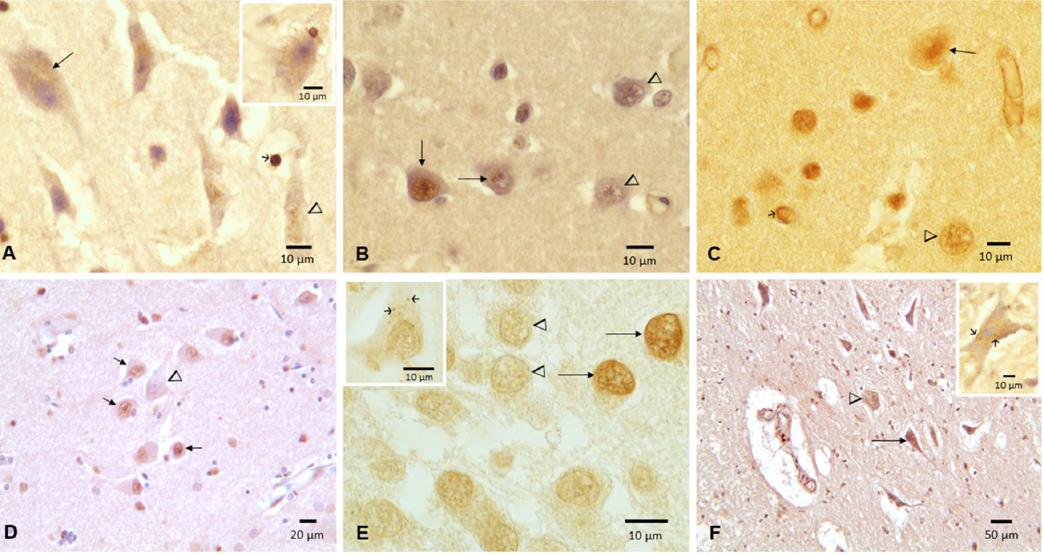
Figure 6. TDP-43 Immunohistochemistry in frontal and temporal cortex, hippocampus and cervical motor neurons. ( A ) Twenty-four y old male showing a frontal pyramidal neuron with negative nu- clear IR and dash-like cytoplasmic positive IR (long arrow), a pyramidal neuron with cytoplasmic IR and negative IR nucleus (arrowhead) and a glial cell with strong nuclear IR (short arrow). Insert shows a coil tangle in an oligodendroglia cell close to a frontal motor neuron with negative IR nu- cleus and a cytoplasmic IR. DAB counterstained with hematoxylin. ( B ) Twenty-five y old male tem- poral cortex showing unremarkable neurons with strong nuclear IR (long vertical arrow) con- trasting with nuclear negative IR (arrowheads) and one neuron with negative nuclear IR and a small cluster of IR positive granules (horizontal arrow). ( C ) Forty-two y old male temporal cortex with normal neurons with strong nuclear IR (long arrow), neuronal negative nuclear IR (arrowhead) and coil tangle in an oligodendroglia (short arrow). ( D ) Seventy-five y old hippocampus CA2 neurons with nuclear IR (short arrows) and negative nuclear IR (arrowhead). ( E ) Same case as ( D ), dentate hippocampal gyrus neurons with strong nuclear IR (arrows) contrasting with nuclear negative IR (arrowheads). Insert is a hippocampal neuron in CA3 in the same subject showing a negative nuclear IR and a few positive cytoplasmic granules. ( F ) Sixteen y old male cervical (C2) anterior horn motor neuron with negative nuclei (arrowhead) and one neuron with cytoplasmic IR (long arrow). Insert: This cervical motor neuron in the same child exhibits a negative IR nucleus and a few positive IR cytoplasmic granules. 4. Discussion Intracellular accumulation of abnormal misfolded proteins is the critical neuropatho- logical feature of ALS, FTD, Alzheimer’s and Parkinson’s diseases and exposure to par- ticulate matter air pollution has been described as a strong risk factor for Metropolitan Mexico City (MMC) young residents [1–4]. Mexican urbanites exposed to complex mix- tures of air pollutants, including PM 2.5 above current EPA US standards and highly toxic UFPM have CSF TDP-43 concentrations exponentially increasing with age. TDP-43 is the target protein associated with ALS and fronto-temporal dementia (FTD) [39–44,66–68]. Remarkably, concentrations of TDP-43 in cisternal CSF with averages of 572 ± 208 pg/mL forecasted cortical and subcortical TDP-43 pathology, while averages of 232 ± 130 pg/mL were associated with no TDP-43 brain pathology in any of the study subjects. Our neuro- pathology findings in the six MMC individuals included loss of normal nuclear TDP-43 expression and development of cytoplasmic aggregations in non-motor and motor neu- ronal groups and involved the olfactory bulb, brainstem and cervical motor neurons. Our previously published MMC cases [2] with TDP-43 pathology involved non-motor nuclei, as described in the work by Pandya [67]. Pandya et al. investigated 79 ALS cases using a